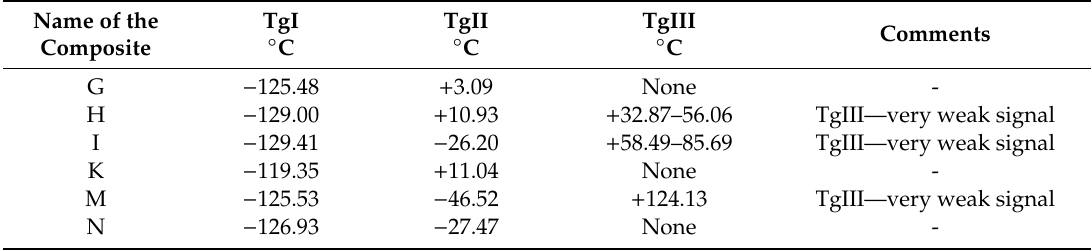
Table 6. Results of Tg determinations obtained for PSUR-based UV-cured composites containing reactive ILs. Composites prepared without IL (A) and without any solvent and lithium salt (N) were included for